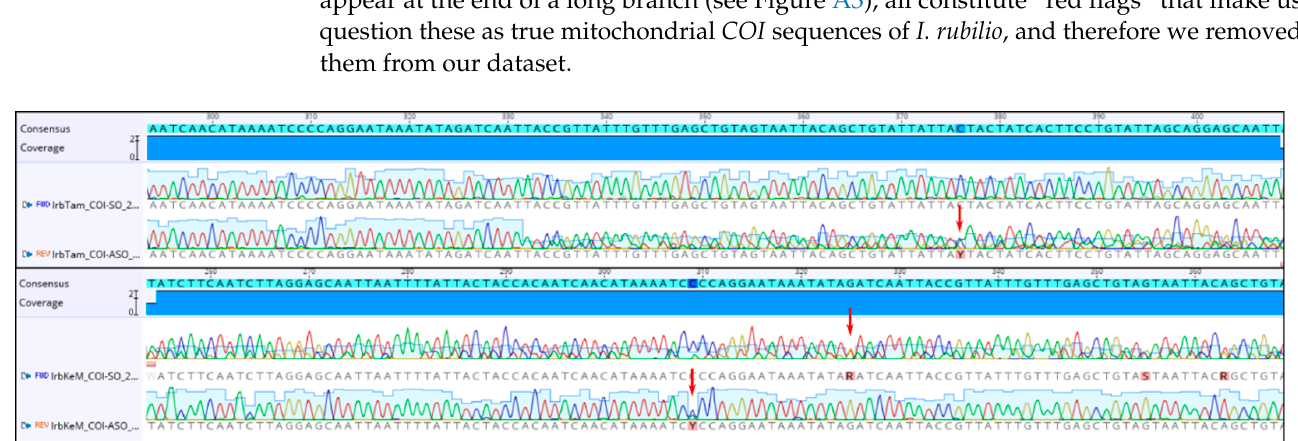
Figure A5. Screenshot of sections of two chromatograms of the Ischnura rubilio COI sequences obtained in this study, showing the messy but in some places readable chromatograms. The red arrows point to the double peaks which were interpreted as ambiguity-coded bases by the software.